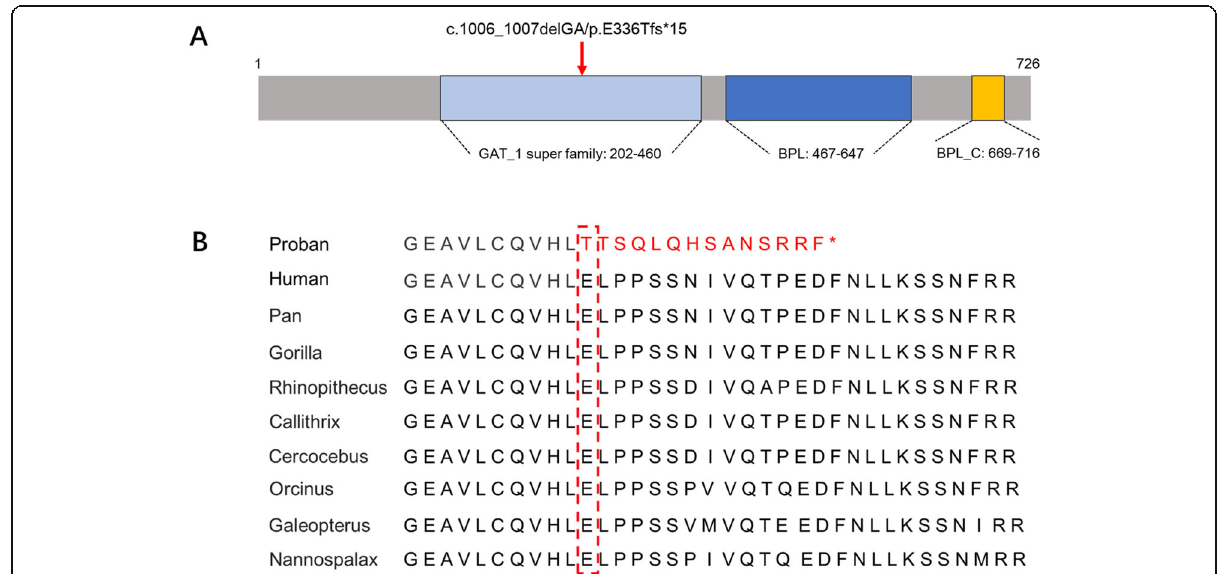
Fig. 2 a Domains structure of HLCS protein. The novel frameshift mutation identified in the proband is indicated by a red arrow. b Conserved amino acid sequences of HLCS (amino acid 336, highlighted by a red box) and the predicted truncated HLCS caused by the frameshift mutation (c.1006_1007delGA) identified in this